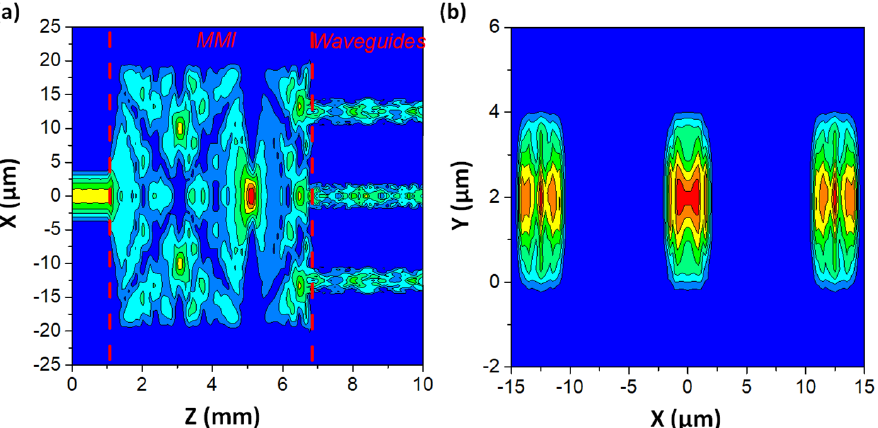
Figure 7. ( a ) BPM simulation (at 600 nm) of light field propagation along a 40 µm × 5624 µm MMI coupler, allowing for the simultaneous probing of 3 waveguides with an SMF28 (XZ-plane). ( b ) Corresponding output light distribution (XY-plane) where the distance between two consecutive waveguides is 12.5 µm.